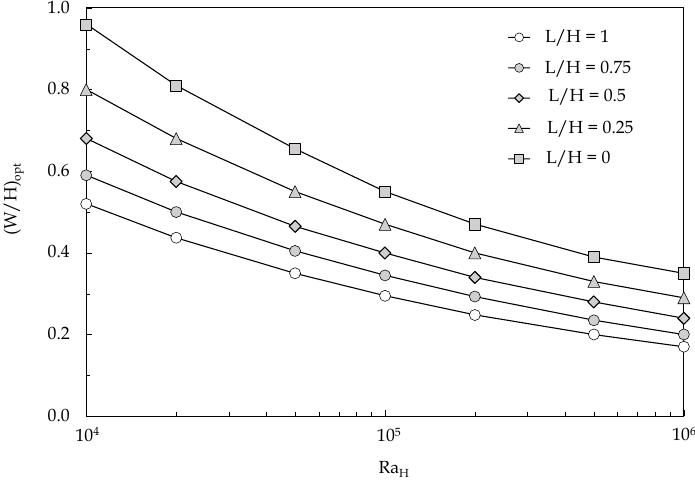
Figure 12. ( W / H ) opt vs. Ra H using L / H as the parameter. The whole set of numerical results obtained for the optimal distance ( W / H ) opt and the corresponding peak-value of the average Nusselt number, denoted as Nu opt , can be correlated by using the following pair of dimensionless correlating equations obtained using a multiple regression method: